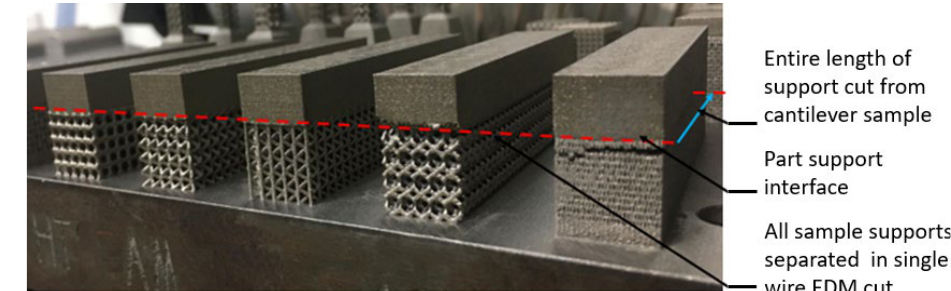
Figure 7. Printed cantilever sample showing the location for support